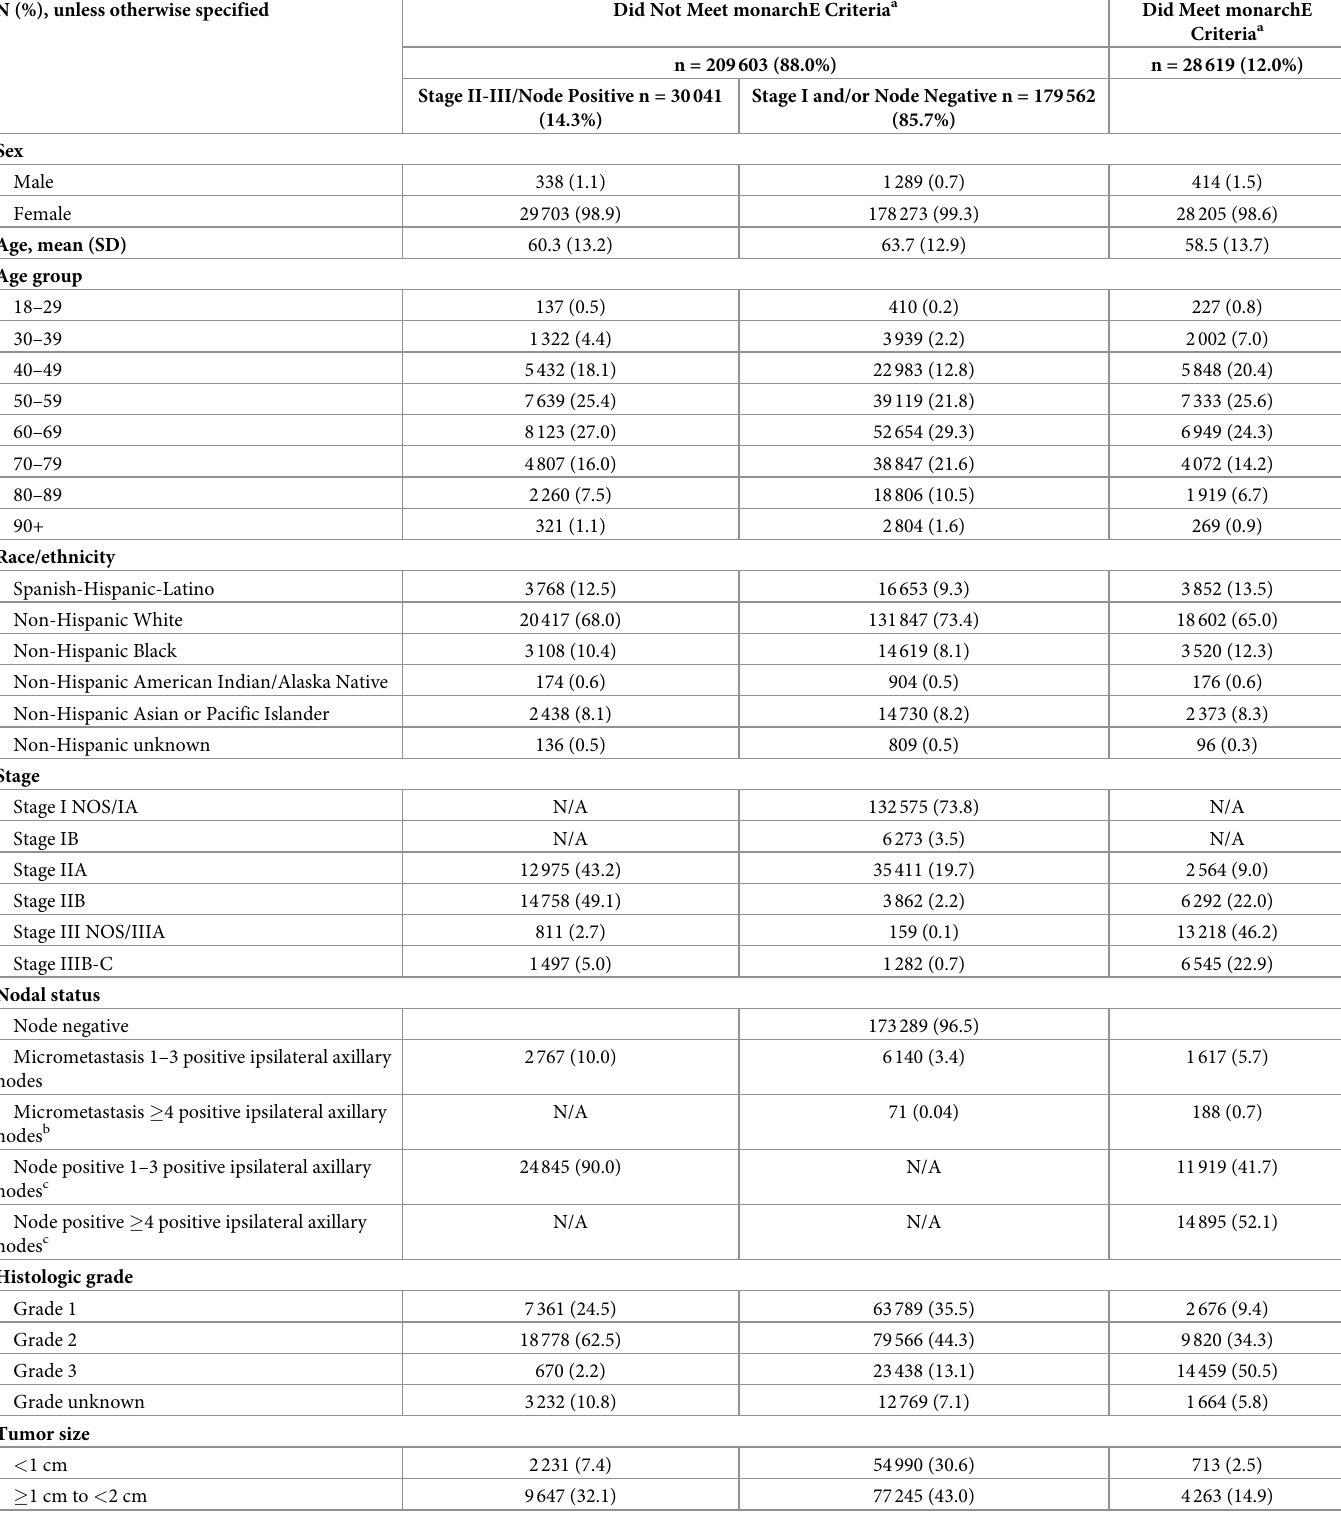
Table 3. Characteristics of patients within the HR+, HER2- subtype, stratified by monarchE clinicopathological high-risk inclusion criteria a . N (%), unless otherwise